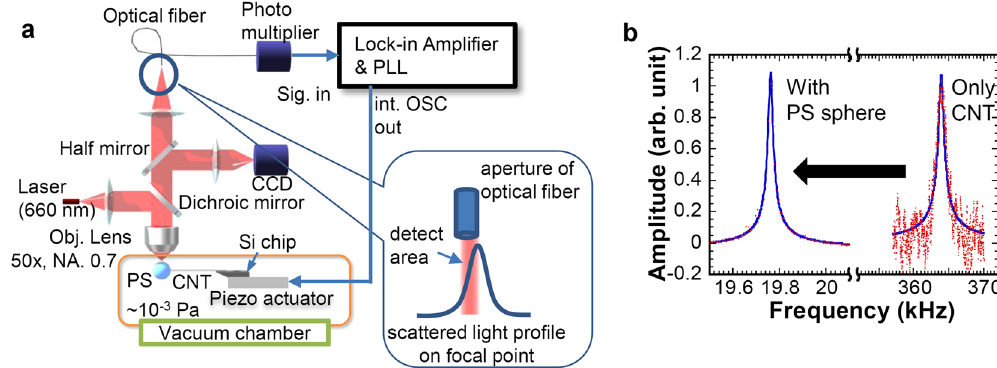
Figure 2. Measurement setup and resonance curve: ( a ) Schematic of measurement setup for resonance properties of the CNT-PS mechanical resonator. ( b ) Resonance properties before and after attachment of the PS